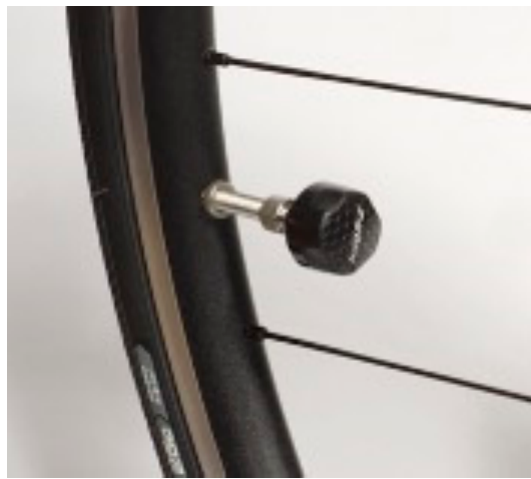
Figure 1. The tire pressure sensor is attached to the valve stem of the bicycle rear wheel.